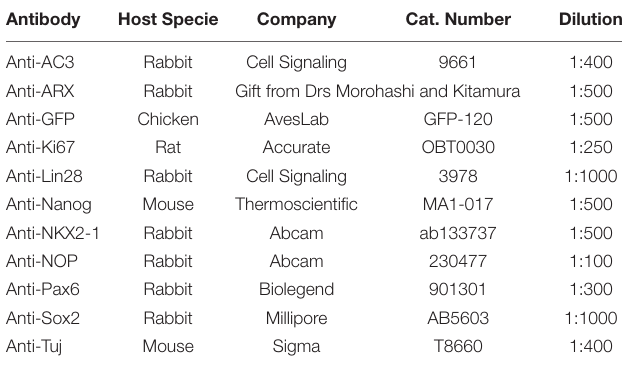
TABLE 1 | Antibodies used for